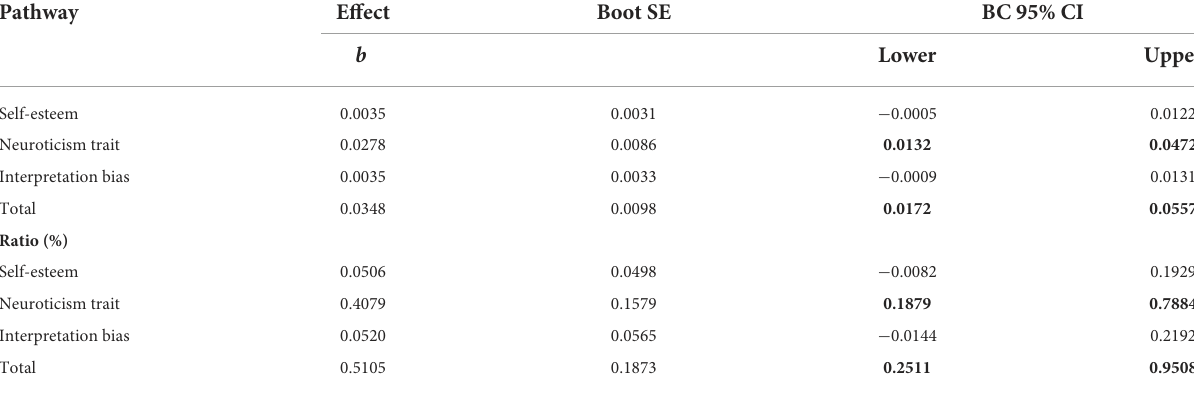
TABLE 3 Indirect effect of school bullying intensity (quantity) on psychotic experiences.